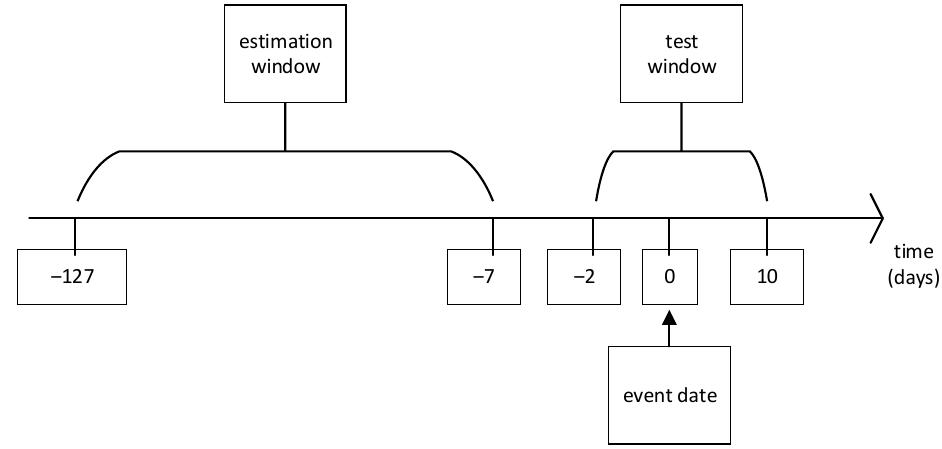
Figure 1. Graphical presentation of the conducted research. Source: Own calculations.